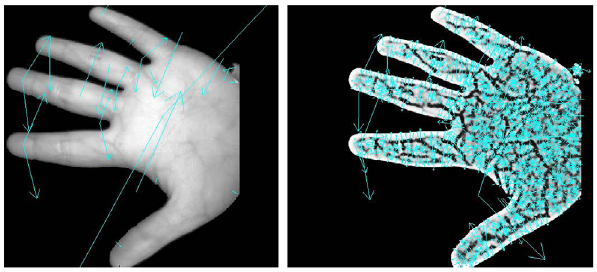
Figure 4. Feature extraction before preprocessing (Left) and after preprocessing